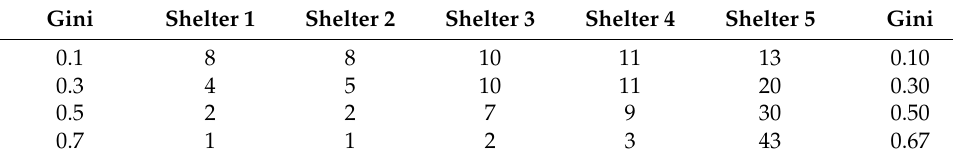
Table A3. Inputs for the simulation when the total demand is 50.